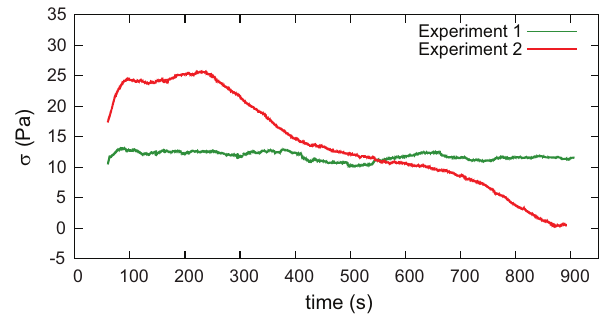
Fig. 8. Convergence parallel normal stress recorded in the back of the overriding plate in Experiments 1 and 2. In Experiment 1, the recorded compressive stress is due to the flexural rigidity of the plate which resists bending. In Experiment 2, the stress at the beginning of the experiment is due to the combined effects the flexural rigidity and high interplate friction. However, during Experiment 2, the compressive stress decreases because the subducted slab becomes longer and its pull becomes stronger. Fig. 9. Side images of the model in Experiment 2. The negative buoyancy of the subducted lithosphere tends to steepen the